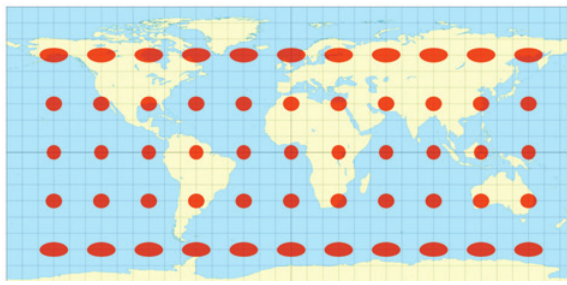
Fig. 12. Map of the world in an equirectangular projection with Tissot’s ellipses of distortion (http://en.wikipedia.org/wiki/Tissot’s_indicatrix) Finding the circumference of a plane ellipse of